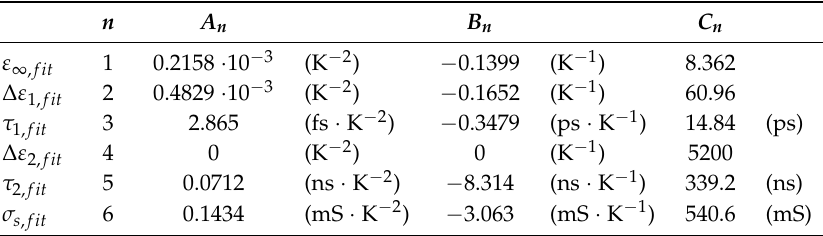
Figure 16. Temperature dependent Cole-Cole parameters (blue circles) of blood and the corresponding second order polynomial fit (red curves). Table 4. Temperature coefficients of the second order polynomial fit to the temperature dependent Cole-Cole parameters of